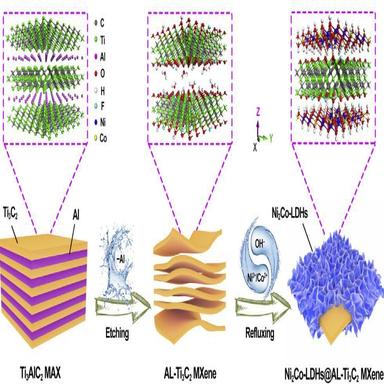
(a) TEM image of an exfoliated AL-Ti3C2 MXene, the inset is the corresponding SAED pattern. (b) AFM image and height information of one exfoliated AL-Ti3C2 MXene. (c) Crystal structure of Ti3C2 MXene monolayer. (d) SEM image of the Ni2Co-LDHs@AL-Ti3C2 MXene composite. (e) Topview TEM image of the Ni2Co-LDHs@AL-Ti3C2 MXene composite, the inset is the corresponding SAED pattern. (f-h) Crosssectional TEM images at low and high magnification. (i) Dark-field scanning TEM image of one Ni2Co-LDHs@AL-Ti3C2 MXene fl